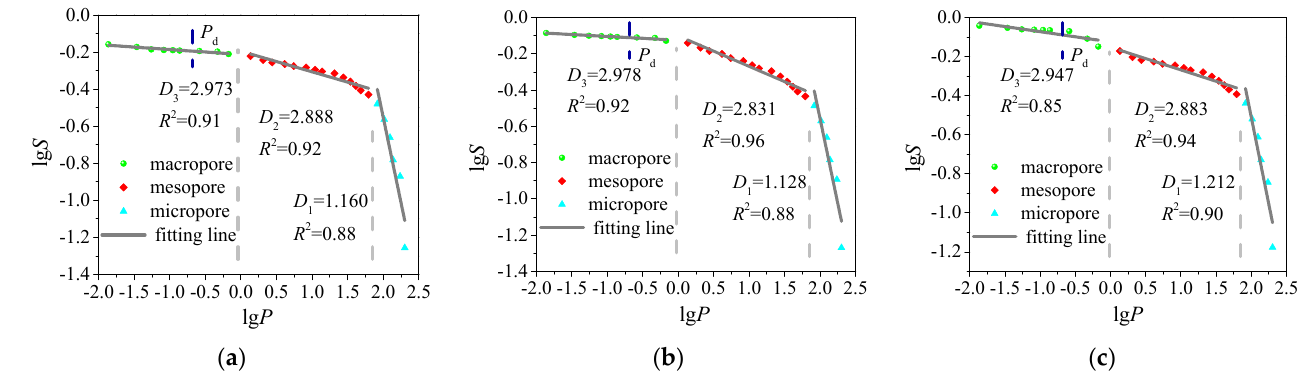
Figure 5. The calculation of multi-scale fractal dimensions, based on MIP. ( a ) M1, ( b ) M2, and ( c ) M3.